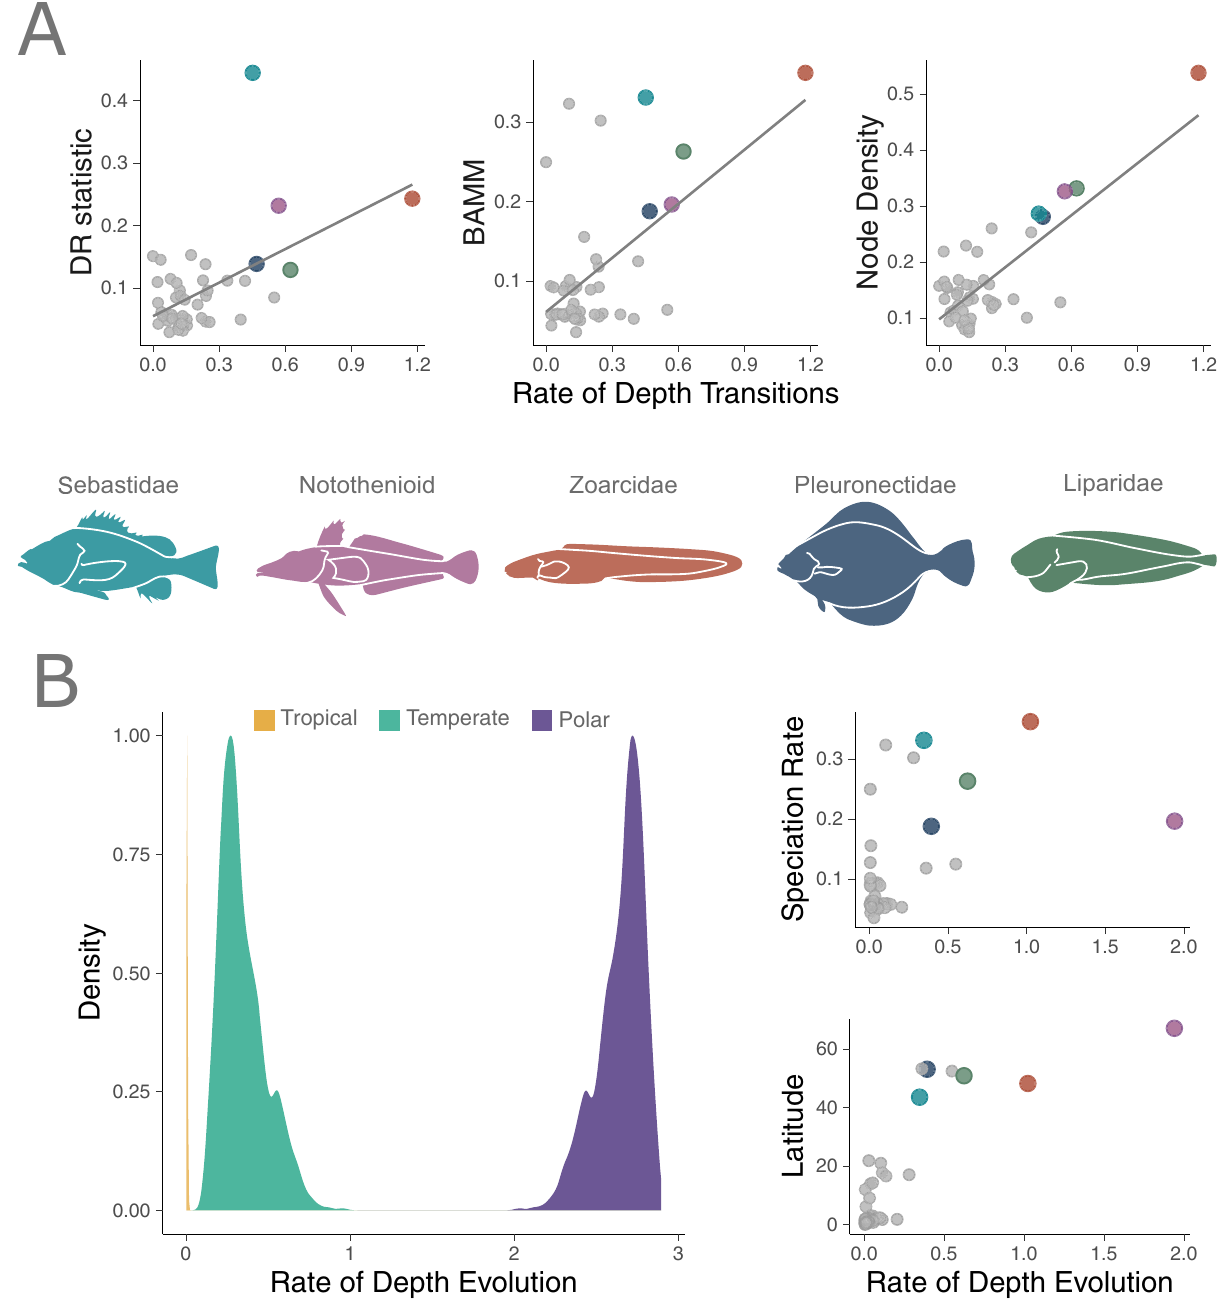
Fig. 2 | Positive relationship between latitude, rates of depth evolution, and speciation rate largely fueled by the fi ve focal lineages. The relationship between different speciation rate metrics and the clade-speci fi c rate of depth transitions ( A ). Focal clades are color coded on each plot. Results from the state- dependent relaxed-clock model of Brownian motion showing the density